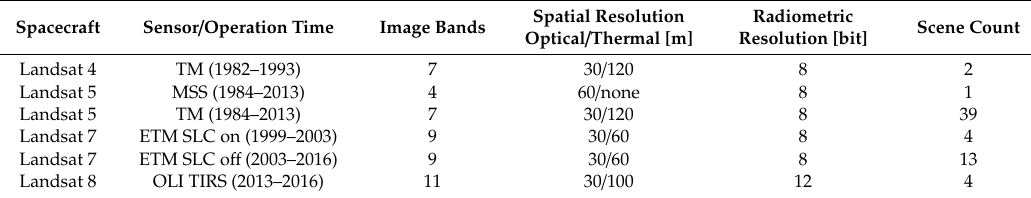
Table 2. Landsat sensor characteristics and dataset overview.